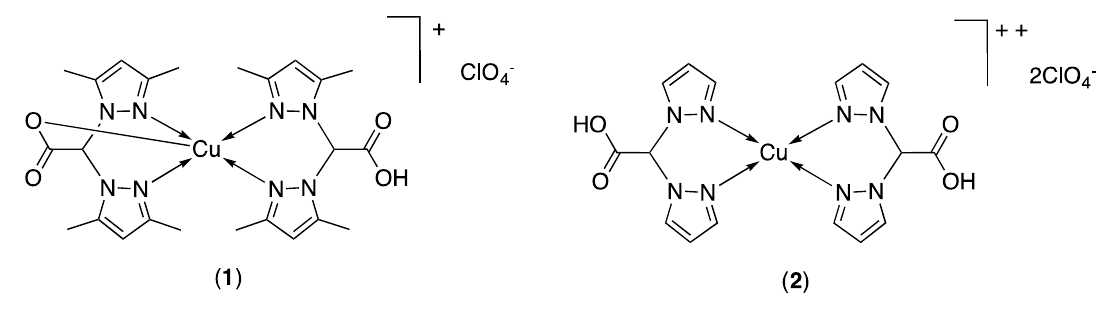
Figure 1. Structure of compounds 1 and 2 .